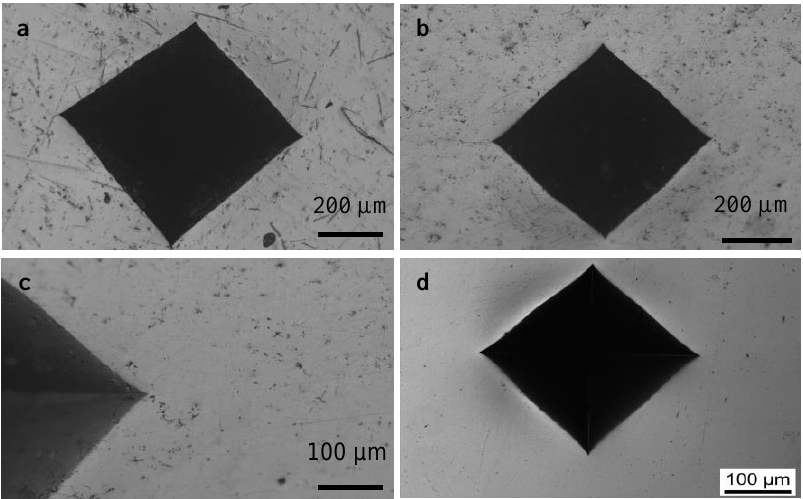
Figure 2. Vickers indents made in a variety of less-tough glasses, showing a surprising lack of crack La Co Cu Ni Al at 491 N; and ( d ) Fe 55 5 10 10 20 appear to be tougher than other glasses with similar